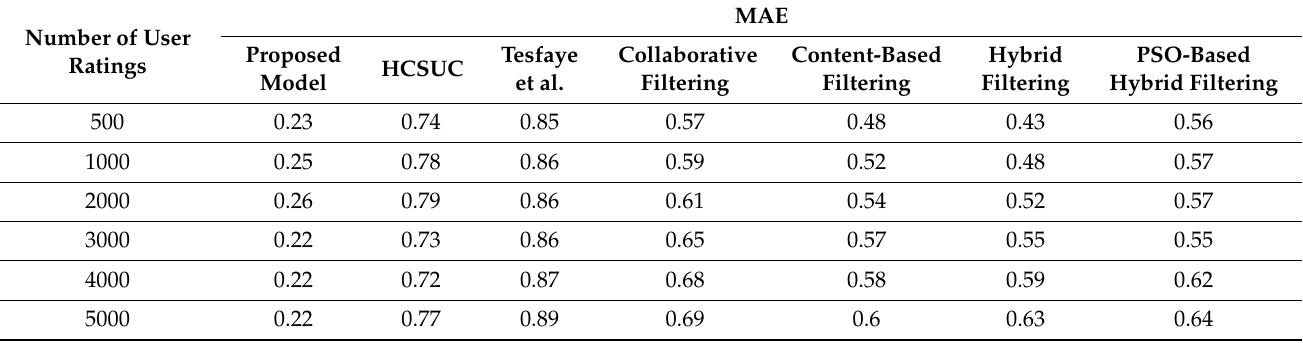
Table 17. Comparison of MAE with the proposed model and existing